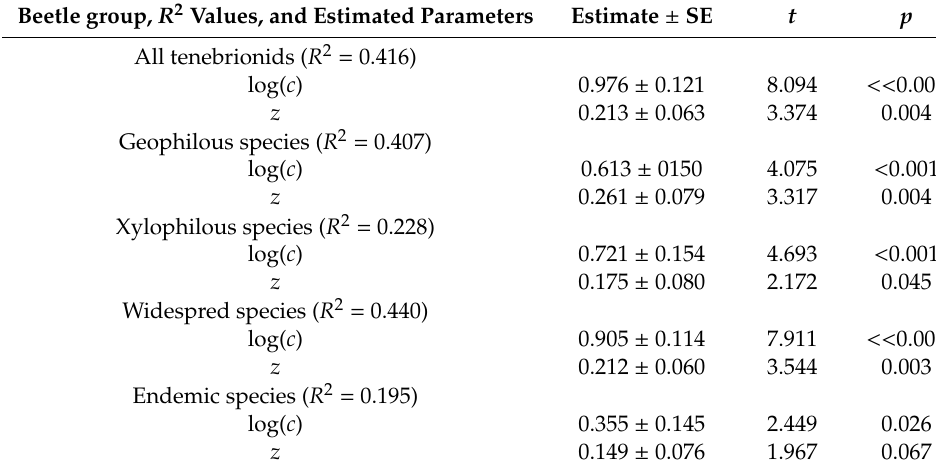
Figure 3. Species-area relationship for tenebrionids in Italian reserves: ( a ) geophilous species, ( b ) xylophilous species, ( c ) widespread species, ( d ) endemic species. Table 2. Parameters of species-area relationships (SARs) for tenebrionids in Italian reserves. SARs were modelled using the linearized version of the power function: log( S ) = log( c ) + z log ( A ), where S is the species number, A is area, and c and z are fitting parameters. SE: standard error, t = Student’s t , p = probability, R 2 = goodness of fit.